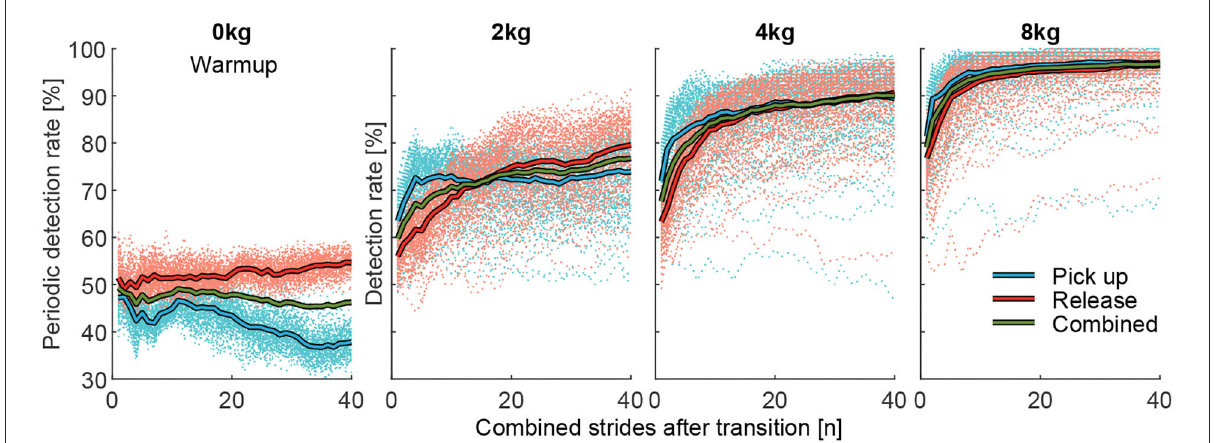
FIGURE7 Detection rate (DR) of the periodic analysis (Warmup, 0kg) and the actual (2, 4, and 8kg) changes in effort for picking up (red) and releasing (blue) the weight, and the combined value (green). Thick solid lines indicate the mean of the respective 127 individuals (dashed lines) muscle combinations. While the Warmup only contains unloaded steady walking, for the periodic analysis, a combination of up to 40 strides was included based on the timing of the 21 intervals (40s each) to show the effect of EMG drift on the DR for a change in walking effort.